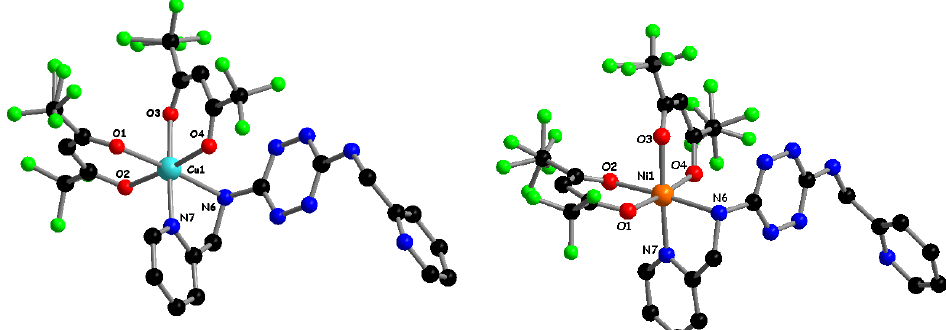
Figure 1. Crystal structures of 1 ( left ) and 2 ( right ) together with a partial atom numbering scheme. Some of the F atoms are disordered. Hydrogen atoms were omitted for clarity.